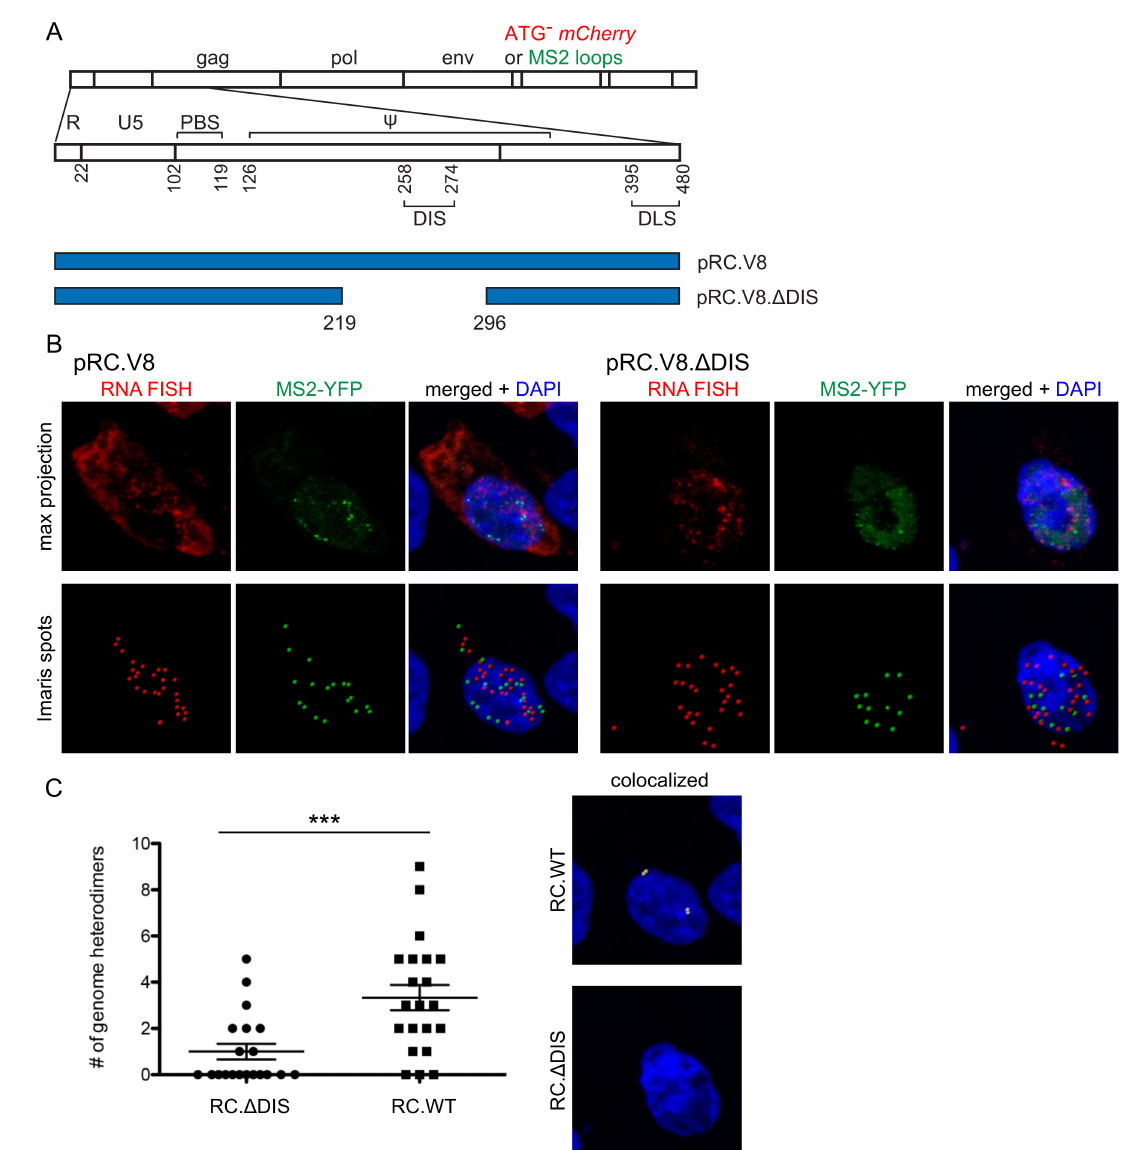
Figure 3. Genome heterodimer formation dependent on presence of dimerization initiation signal (DIS) ( A ) Schematic of pRC.V8 and pRC.V8. ∆ DIS proviral constructs, which contains a 77-nucleotide deletion (bp 219-296) removing the L3 stem-loop DIS. Each construct contains either 24x-MS2 RNA stem-loops or a non-coding mCherry RNA sequence after env ; ( B ) Cells on the left were co-transfected with pRC.V8.ATG-mCherry, pRC.V8.MS2, and MS2-YFP (green) and subjected to mCherry RNA smFISH (red). On the right, cells were transfected with pRC. ∆ DIS.ATG-mCherry, pRC. ∆ DIS.MS2, and MS2-YFP (green) and mCherry RNA smFISH (red) was performed. Cells were imaged through the width of the nucleus, as assessed by DAPI staining, using a 63 × objective at 3.5 × optical zoom. The top rows of each panel show maximum projection images and the bottom row images indicate the location of foci identified using the Imaris Spots function; ( C ) Colocalization of dual-colored foci was analyzed using the Imaris Spots colocalization function (colocalization threshold 0.5 µ m). Statistical significance was assessed by using negative binomial regression model, and a total of 30 cells were analyzed in two biological replicates, (*** p < 0.0001). Histograms were adjusted in the Imaris software for optimal